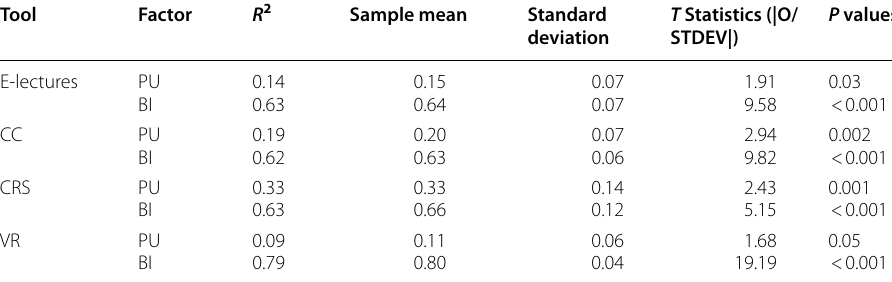
Bootstrap with 10,000 samples. One‑tailed significance testing ***Significant at α < 0.001. Table 5 Structural model results for the factors PU and BI each tool